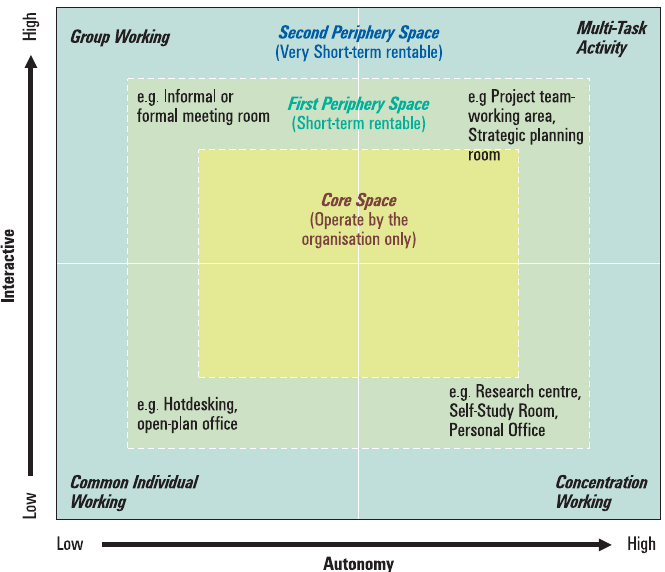
Figure 5. Combination of workspace-portfolio fl exibility models Adapted from: Laing et al. (1998), Gibson and Lizieri (1999) and Ward and Holtham